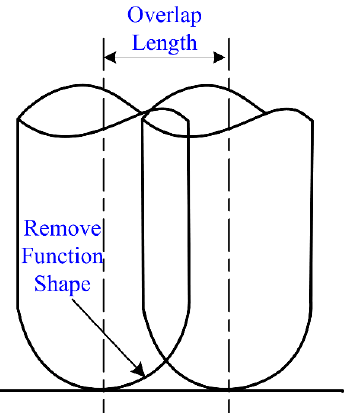
Figure 7. Schematic diagram of the overlapping path.